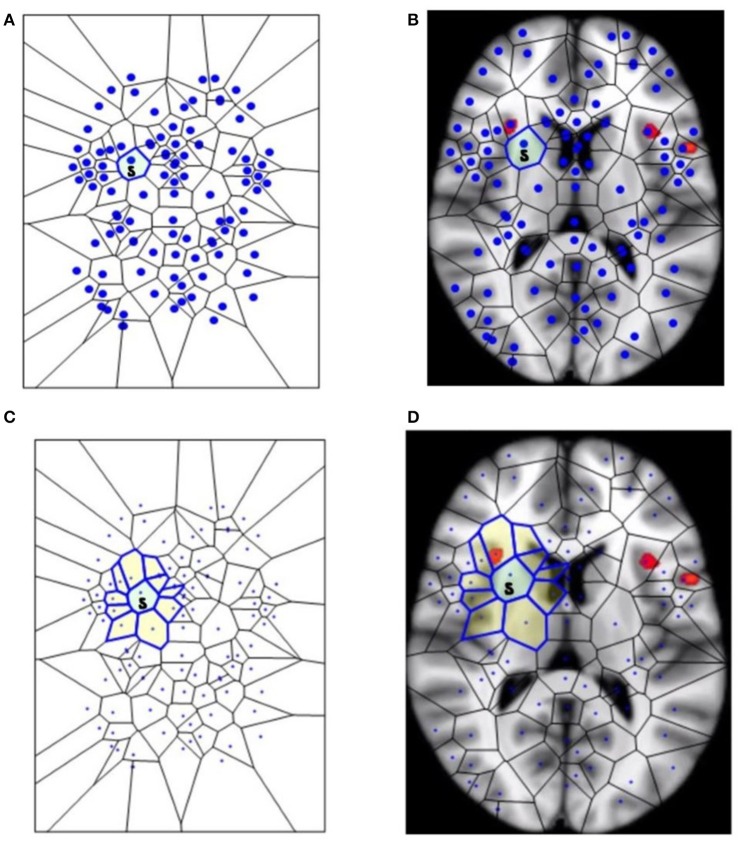
The segmentation of fMRI images into small polygons, which makes it possible to compare the different morphological features displayed by the different groups. (A) Surface tiling of a sample Voronoï region V(s) = . Each region in the tiling represents a generating point with particular fMRI image features, such gradient orientation and brightness. It is also worth noting that no two regions have the same description. For this reason, every Voronoï region has a slightly different shape. This tiling is derived from the fMRI image in (B), which displays Voronoï region V(s) on a fMRI image taken from Mitra (11). (C) Displays a sample maximal nucleus cluster N for a particular generating point represented by the dot • in N. In this Voronoï tiling, the nucleus N has 10 adjacent polygons. Since N has the highest number of adjacent polygons, it is maximal. This cluster N is of particular interest, since the generating point • in N has a gradient orientation that is different from the gradient orientation of any other generating point in this particular tiling. In (D), the maximal nucleus cluster N is shown in situ in the tiling of an fMRI image.